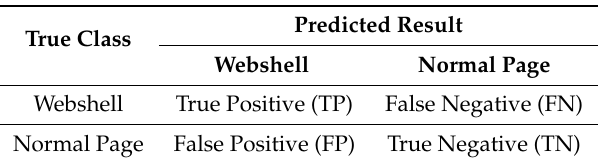
Table 3. Classification confusion